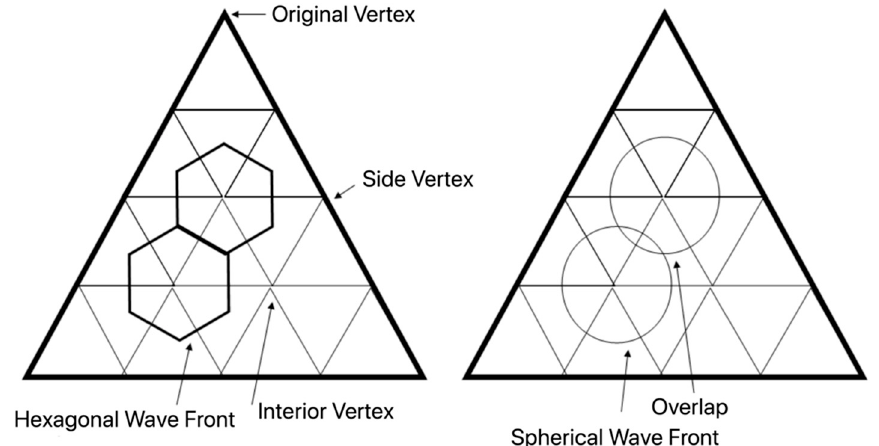
Figure 4. Ray launching representation using the tube and icosahedron ray technique (left) and the cone beam technique .